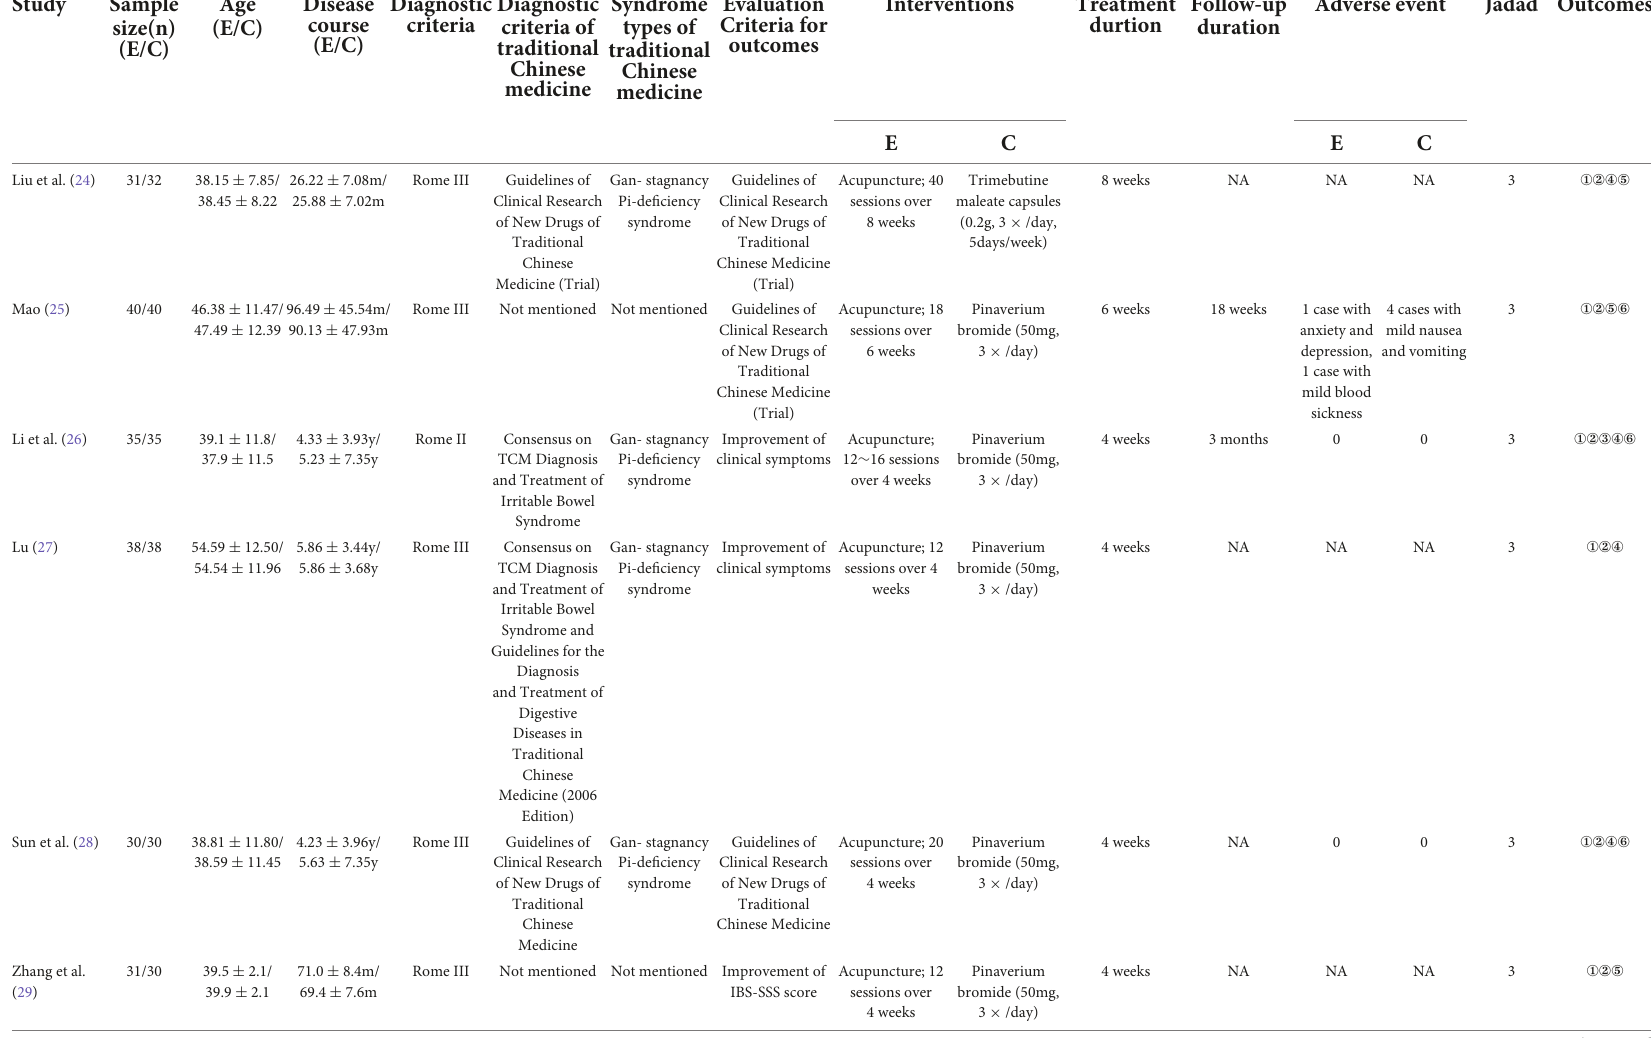
TABLE 1 Basic characteristics of the included studies. Study